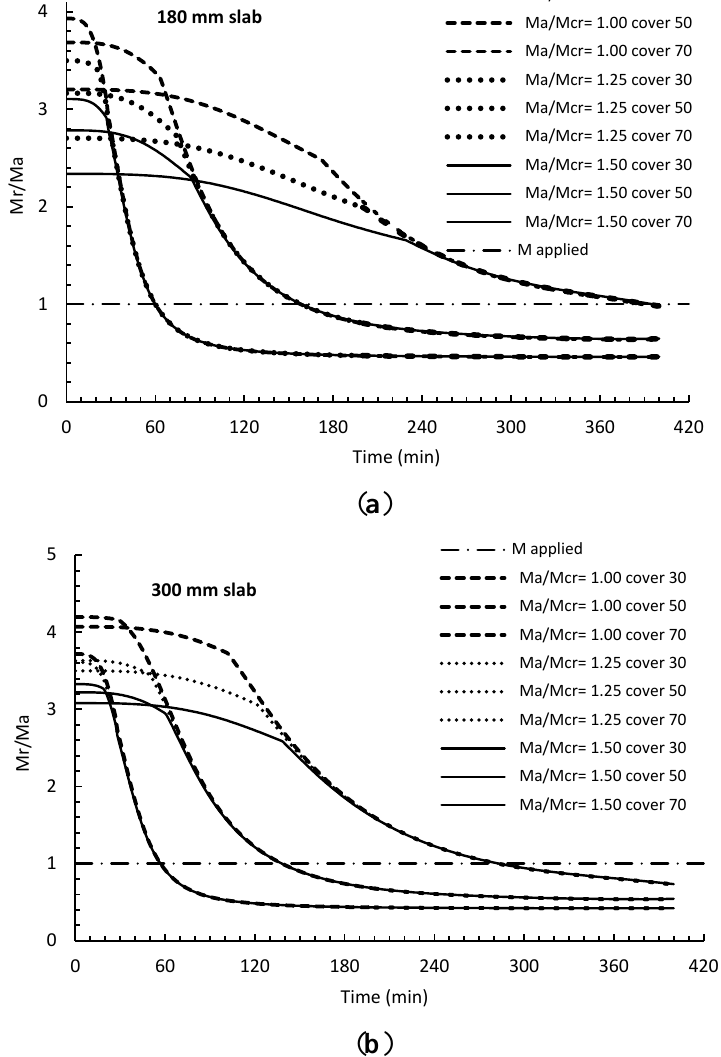
Figure 8. Ratios of M